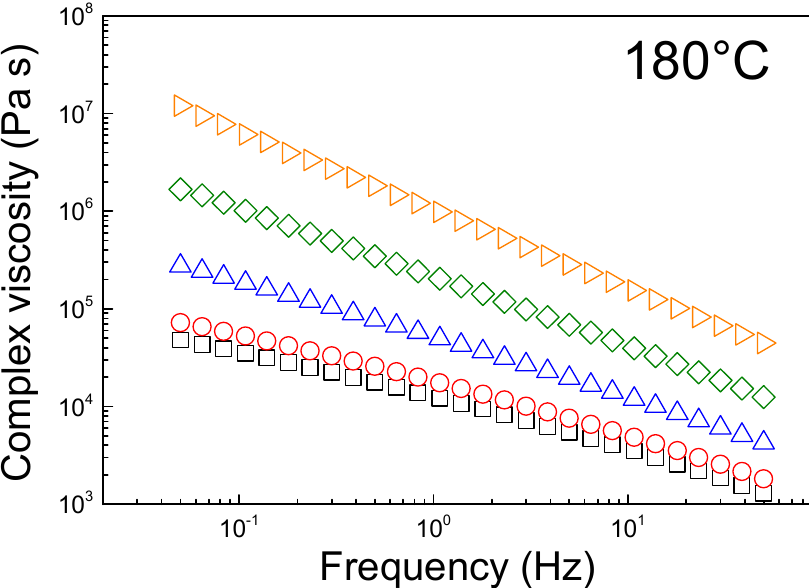
Figure 4. Dependence of complex viscosity on the frequency for various neat HDPE and various HDPE/EG composites at 180 °C, where —neat HDPE, —90/10, —70/30, —50/50, —30/70.